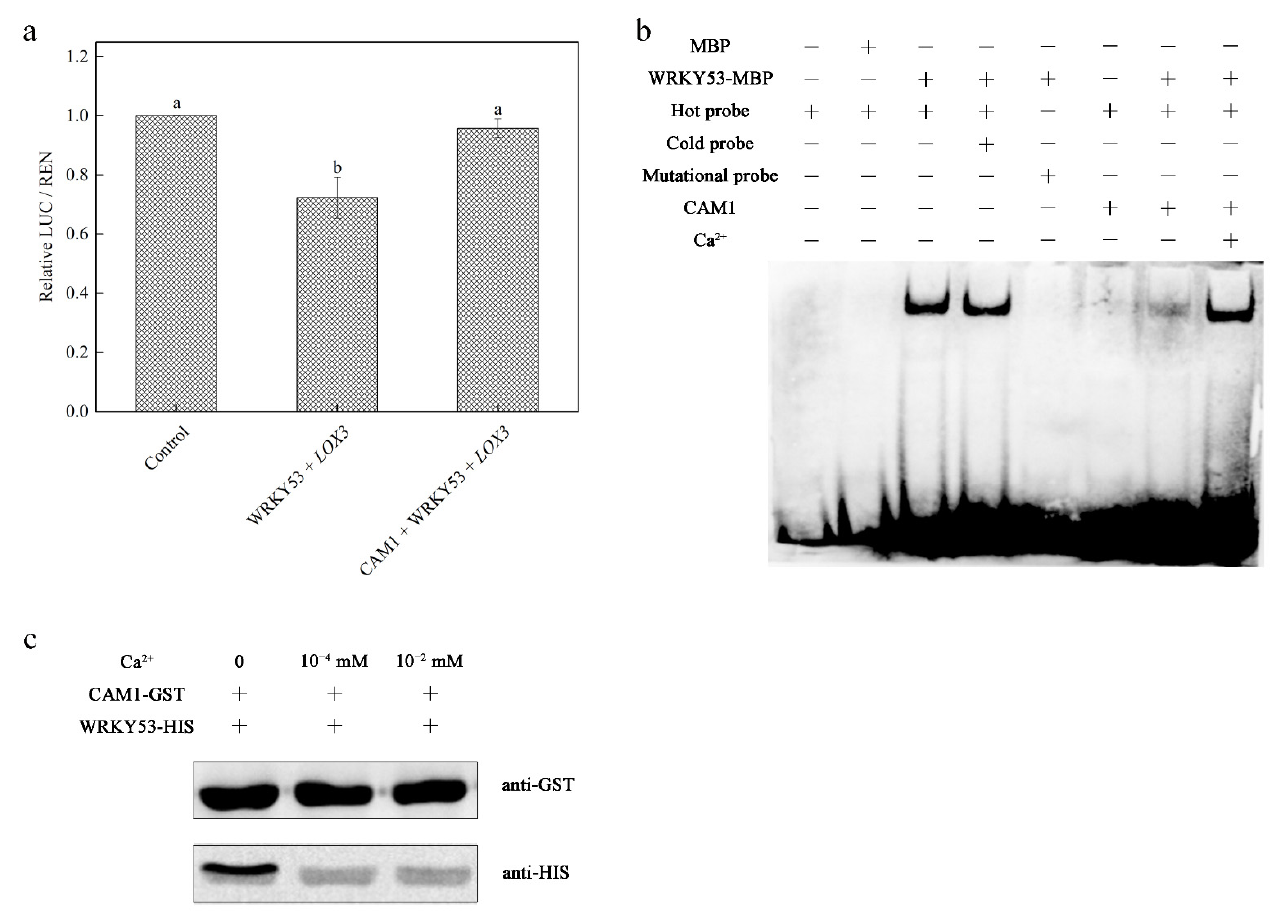
Figure 3. WRKY53 functions as a negative regulator and directly bind to the LOX3 promoter. ( a ) shows that WRKY53 pGreenII 62-SK negatively affects LOX3 expression, and CAM1 pGreenII 62-SK decreased the negative regulation. Error bars denote ± SEM, columns labeled with different letters are significantly different at p < 0.05, Dunnett’s C (variance not neat). ( b , c ) EMSA and pull- down assay showing the effects of calcium and CAM1 on the binding between WRKY53 and the first W-box in the LOX3 promoter. In ( b ), a hot probe refers to a biotin-labeled probe and a cold probe to an unlabeled probe (200-fold the concentration of the hot probe). Ca 2+ concentration is 10 − 2 mM.